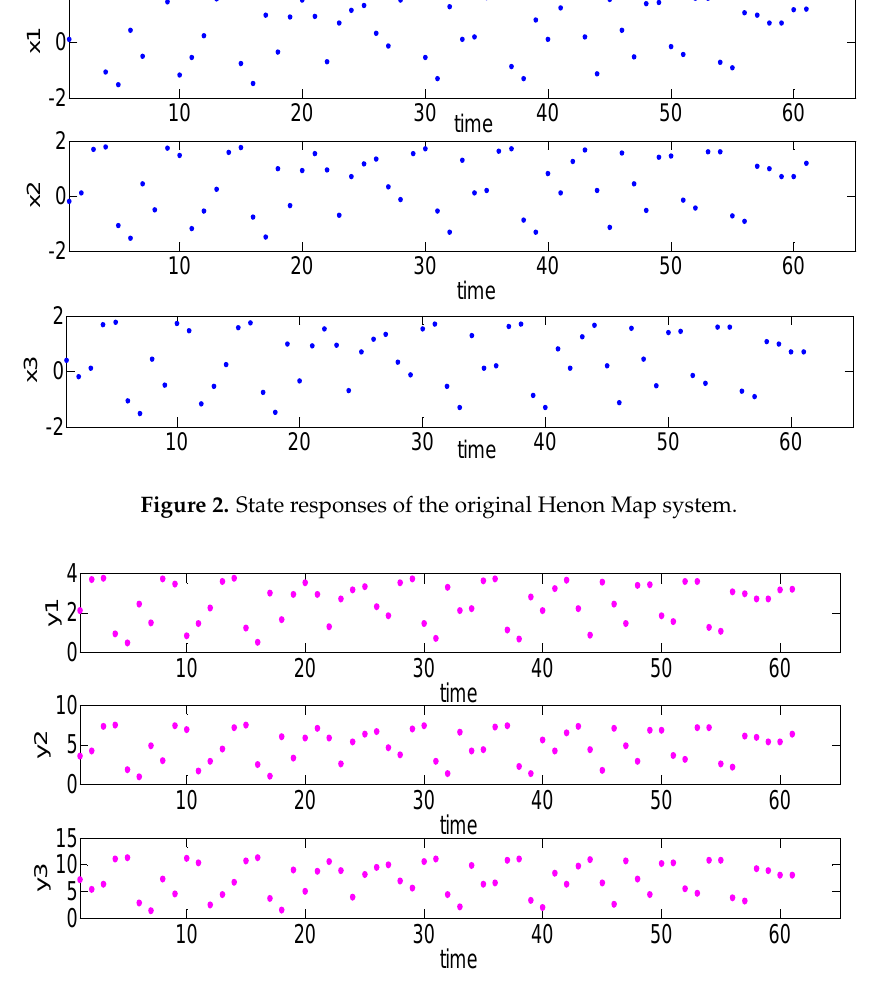
Figure 3. State responses of the adjusted Henon Map system.